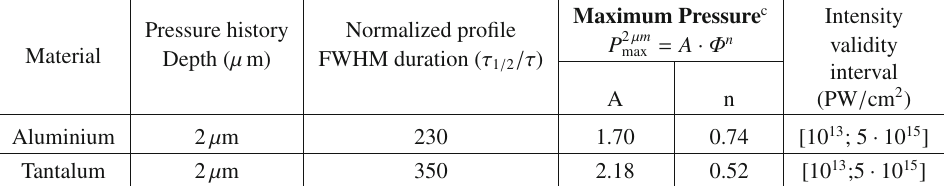
c The table coe ffi cients are compatibles with pressures in M bar order and intensities in PW / cm 2 .